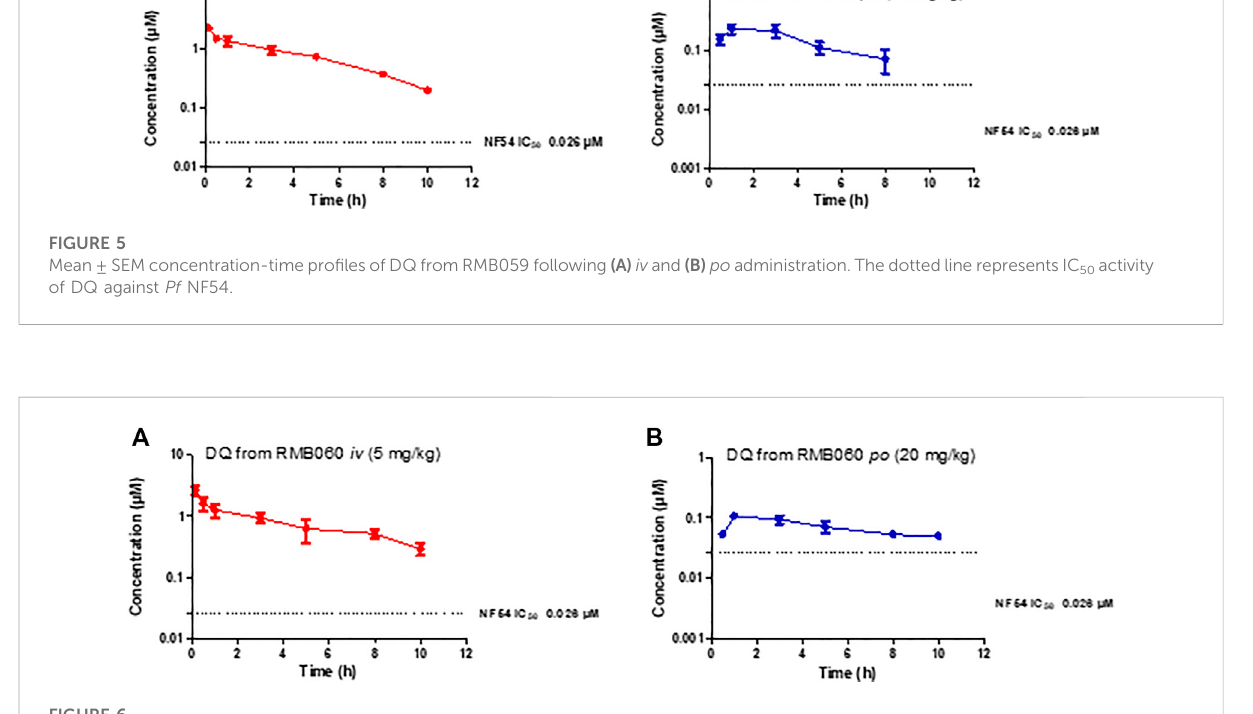
FIGURE 6 Mean±SEMconcentration-time pro fi lesofDQfromRMB060 following (A) iv and (B) po administration.Thedottedlinerepresents IC 50 activity of DQ against Pf